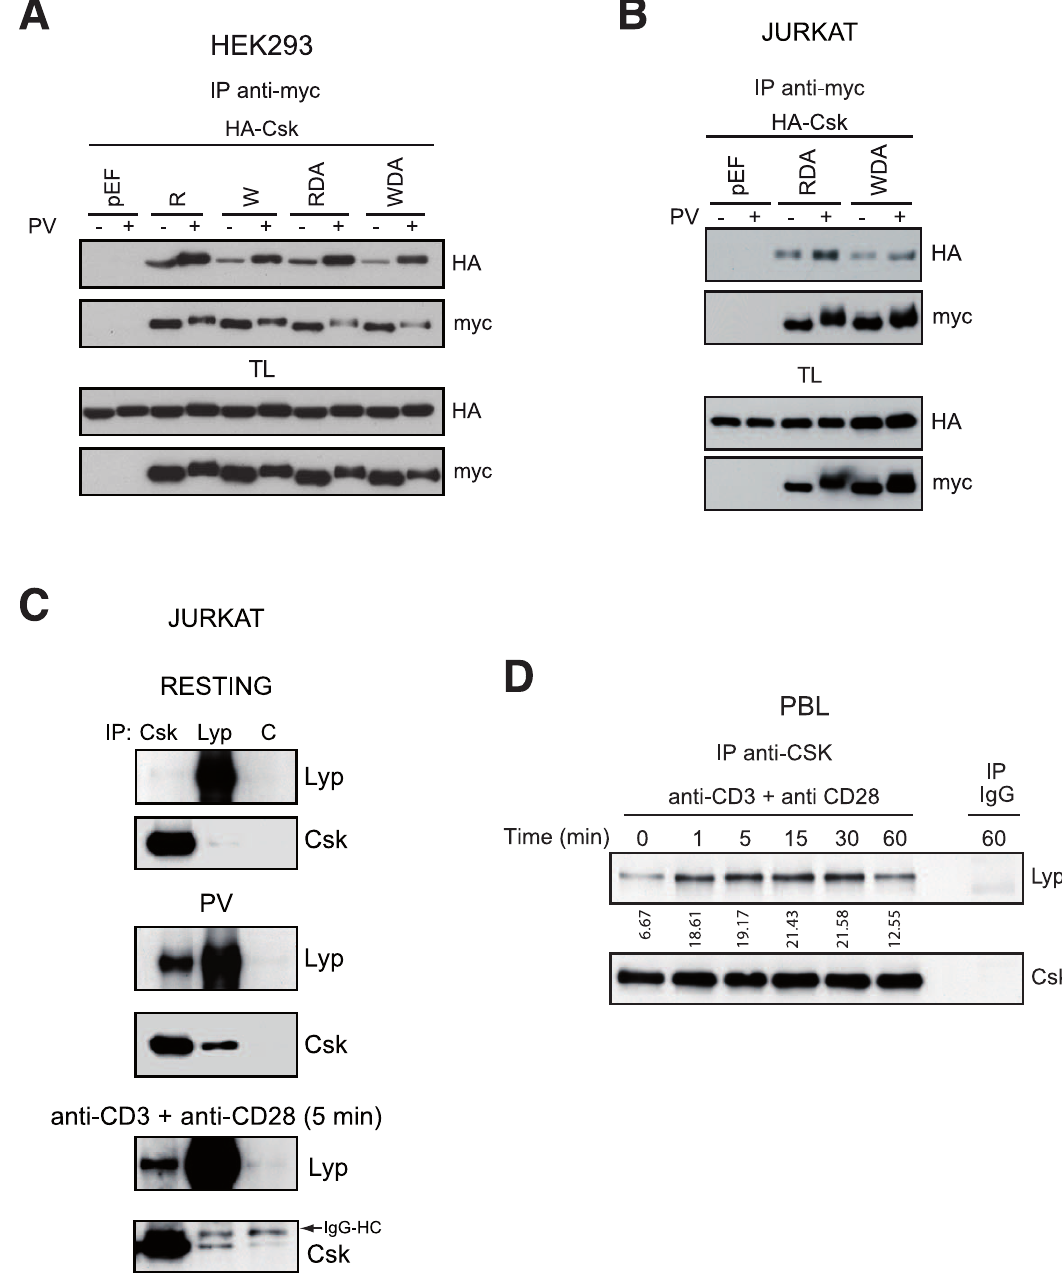
Figure 1. LYP binds to CSK in an inducible manner. A , Total lysates (TL) of HEK293 cells transiently transfected with LYP tagged with the myc epitope and HA-CSK, including the empty vector pEF as control, and treated or untreated with pervanadate (PV) for 5 min were subjected to immunoprecipitation (IP) and immunoblot (IB) with the indicated antibodies. B , Lysates from Jurkat cells transfected with plasmids that express myc- LYPR-DA or myc-LYPW-DA treated with PV for 5 minutes were subjected to IP with anti-myc Ab and then blotted with anti-HA (upper panel) to detect CSK. Similar expression of the proteins in the assay was detected by IB in the TL. C , Lysates of Jurkat cells untreated (resting cells), treated with PV or stimulated with anti-CD3 and anti-CD28 Abs for 5 min were subjected to IP with anti-CSK Ab, anti-LYP Ab, or an irrelevant Ab used as control, and inmunoblotted against endogenous LYP and CSK. D , T lymphocytes obtained from peripheral blood of healthy donors were incubated for the indicated times at 37 u C with medium alone or in the presence of anti-CD3 and anti-CD28 Ab. Lysates from these cells were immunoprecipitated with anti-CSK or an irrelevant Ab (IgG) to show specificity, and the presence of LYP and CSK in the precipitates was detected with specific Abs by IB. LYP blot was measured by densitometry and the values obtained, shown under the blot, are expressed in arbitrary units. doi:10.1371/journal.pone.0054569.g001 corresponds to LYP in cells treated with PV (Figure 1A and B) that P1 and P2 LYP Motifs Bind to CSK can be most likely explained by LYP phosphorylation. The previous data suggested that either Arg620 is less critical than expected for CSK binding or CSK binds LYP through